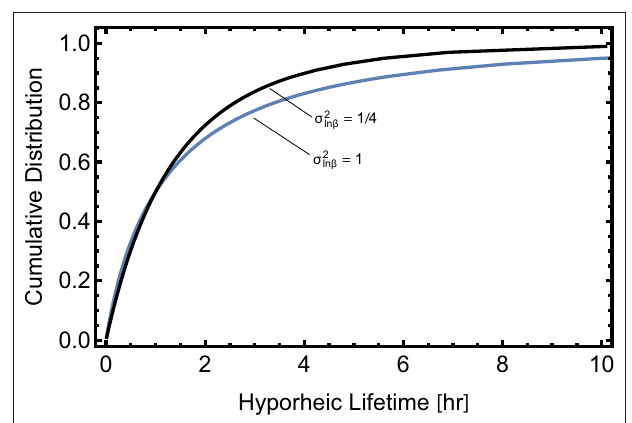
FIGURE 2 | Cumulative distribution of hyporheic lifetime for two choices of the distribution of β , the hyporheic exchange rate coefficient, as calculated from Equation (15). The blue curve is for the reference case, a log-normal distribution of β with with log-variance of 1. The black curve uses a narrower distribution with log-variance 0.25. In both cases, the median travel time was constrained to be